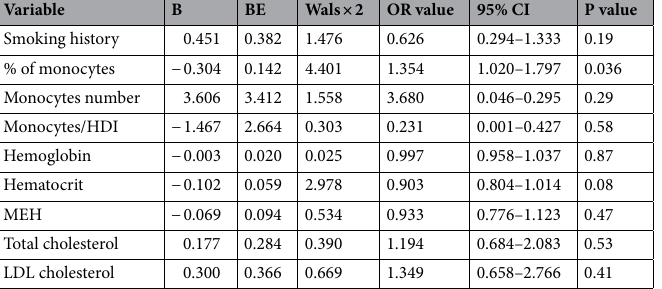
Table 4. Binary logistic regression analysis. Values shown are means ± SD or percentages. MEH mean erythrocyte hemoglobin, HDL high density lipoprotein cholesterol, LDL low density lipoprotein cholesterol.